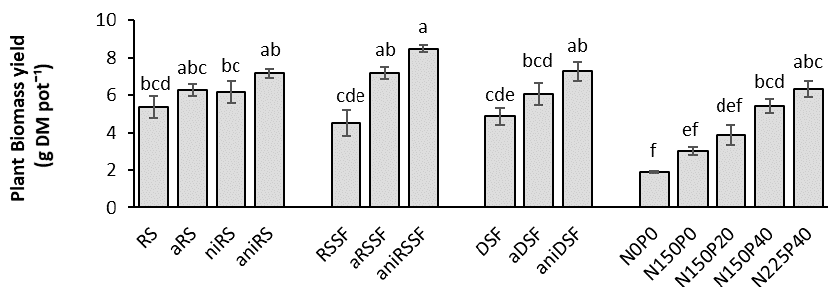
Figure 3. Plant biomass yield for untreated and acidified organic products and reference mineral fertilizers 35 days after sowing (DAS) as mean values of 4 replicates. RS: Raw slurry; RSSF: Raw slurry solid fraction; DSF: Digestate solid fraction; a: Acidified; ni: Nitrification inhibitor; ani: acid + ni; NxPy: mineral N and P reference fertilizer at x mg N and y mg P kg − 1 soil. Error bars represent standard error of the mean ( n = 4). Treatments with di ff erent letters (across all levels) are significantly di ff erent ( p < 0.05) according to the Tukey test.